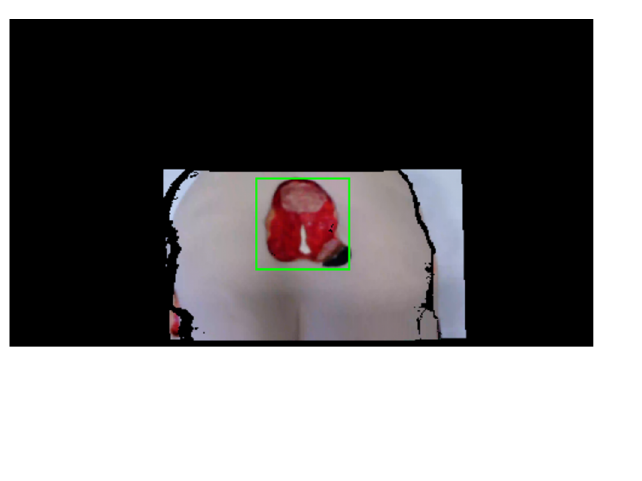
Figure 4. ( a ) Registered RGB-D image with bounding rectangle generated by the detection system; ( b ) 3D visualization of the current (grey) and requested (orange) robot position.